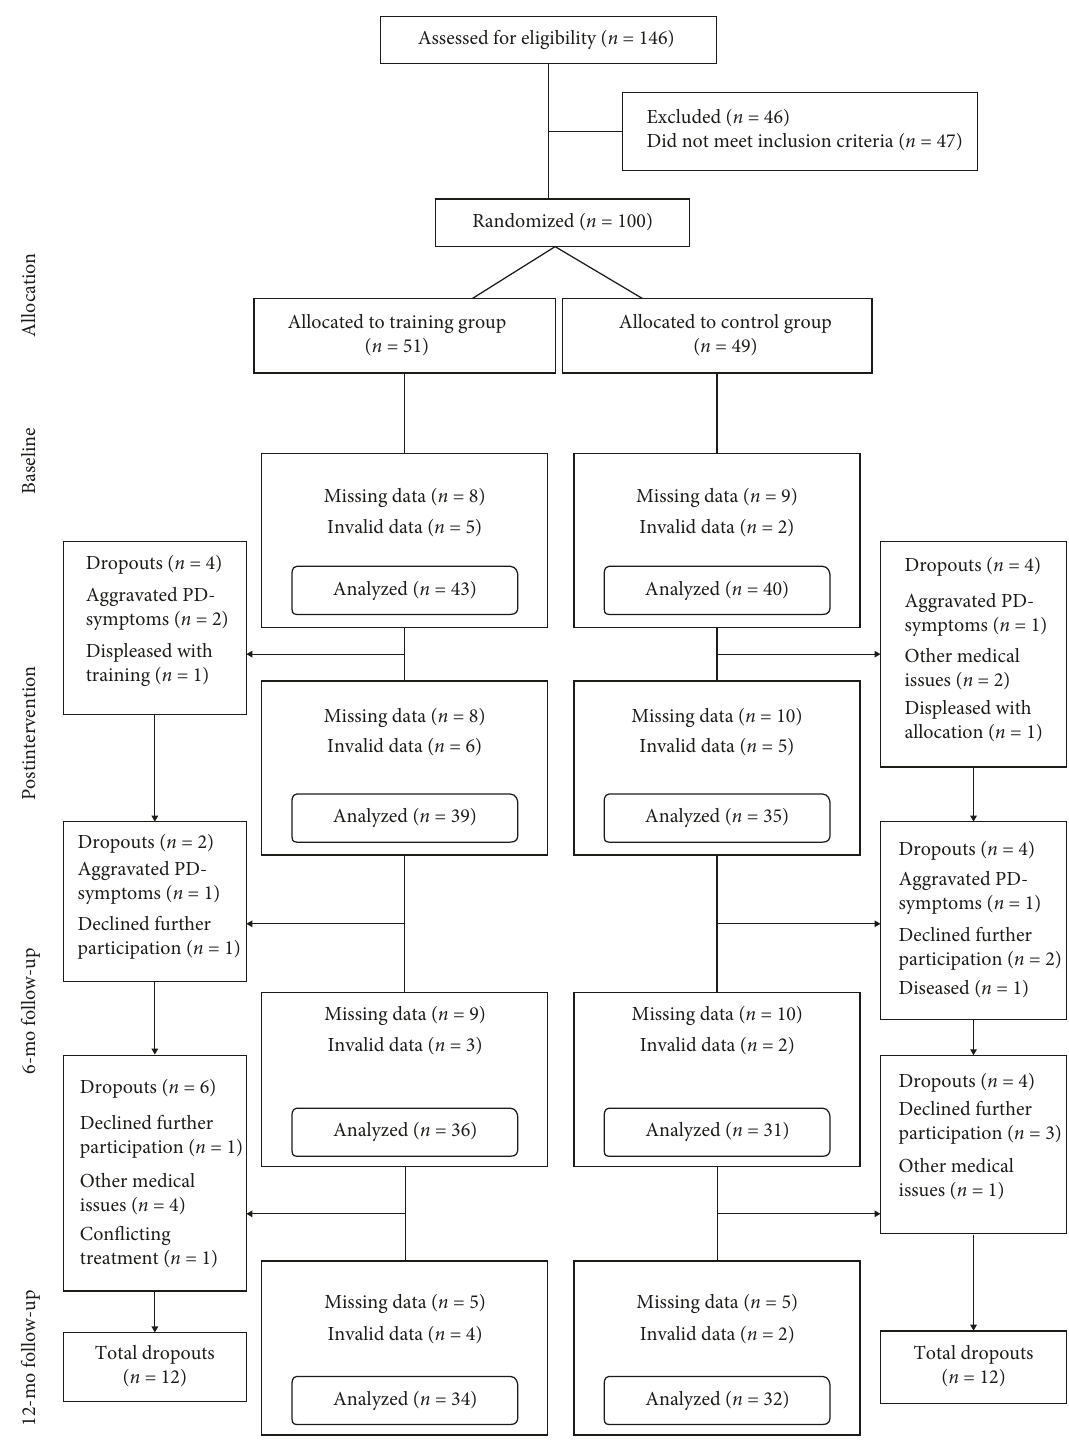
Figure 1: Flow chart of physical activity data from baseline to the 12months